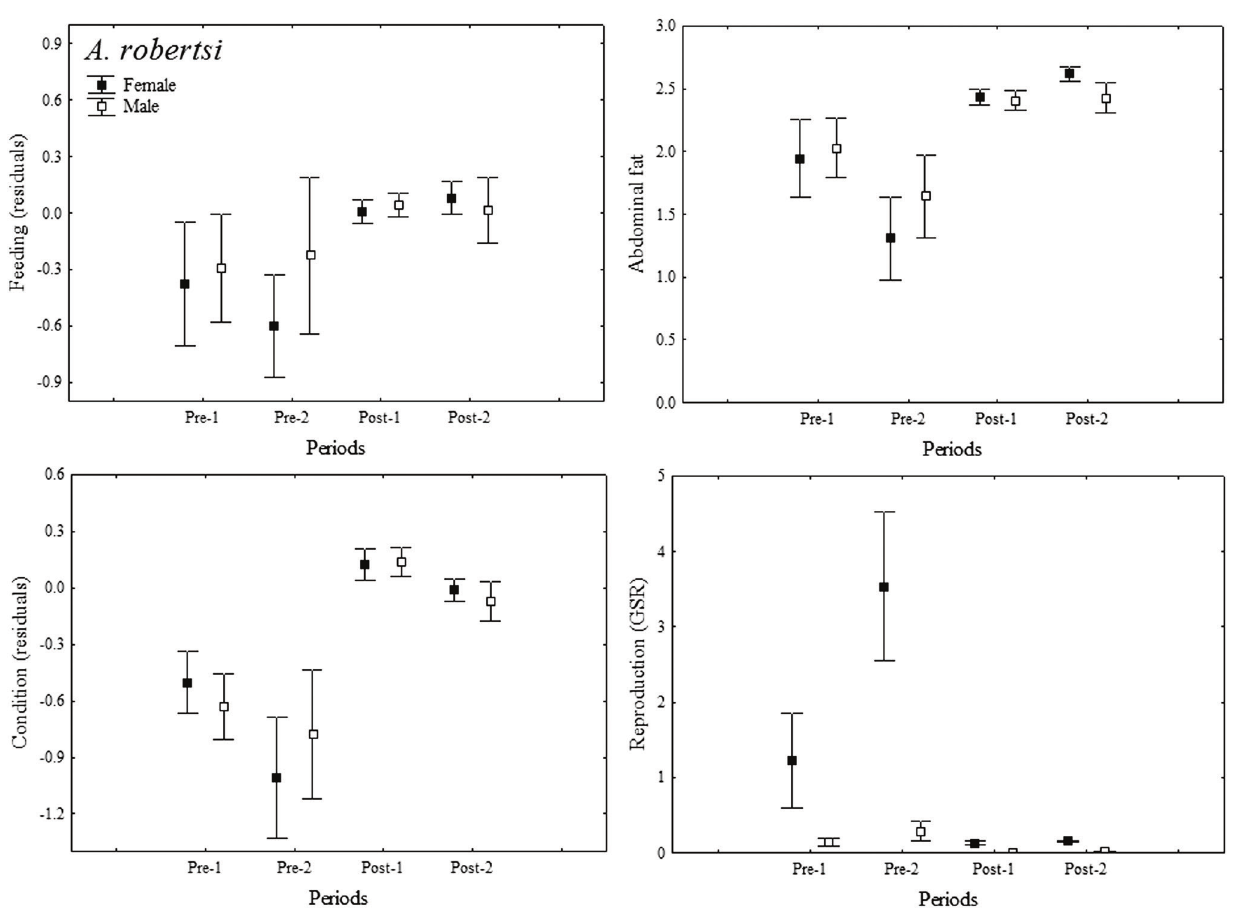
Fig. 2. Variation in feeding activity (standard residuals, regression between LS x WS), visceral fat storage, body condition (standard residuals, regression between LS x TW) and reproductive effort (GSR) of Argonectes robertsi , before (Pre-1 and 2) and after (Post-1 and 2) the construction of Lajeado